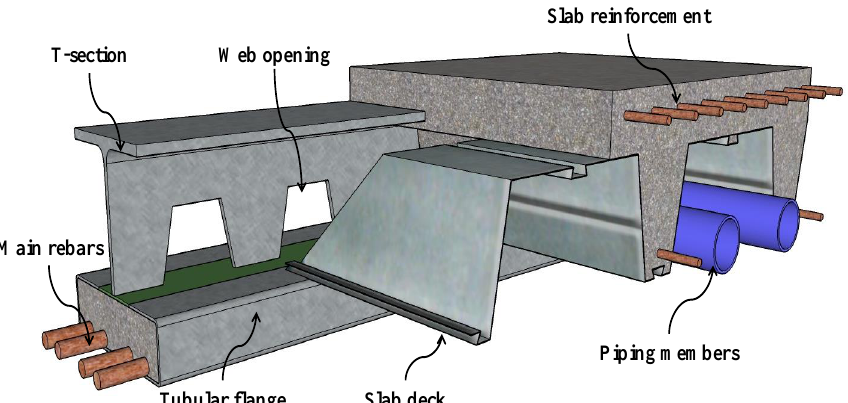
Figure 1. Composite beam system with tubular lower flange.